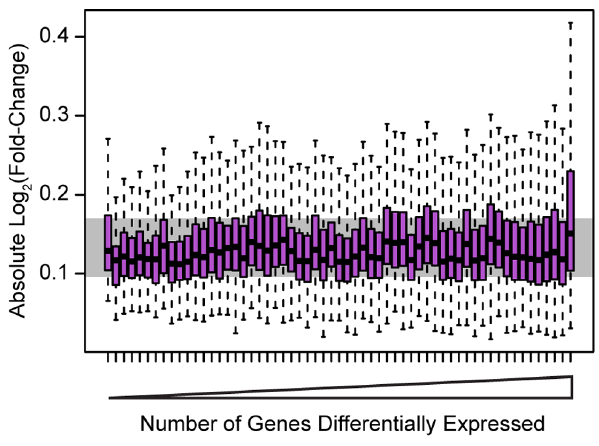
Figure 2. Effect sizes for differentially expressed genes. Boxplots of absolute Log 2 (fold-change) between knockdown arrays and control arrays for all genes identified as differentially expressed in each experiment. Outliers are not plotted. The gray bar indicates the interquartile range across all genes differentially expressed in all knockdowns. Boxplots are ordered by the number of genes differen- tially expressed in each experiment. Outliers were not plotted.